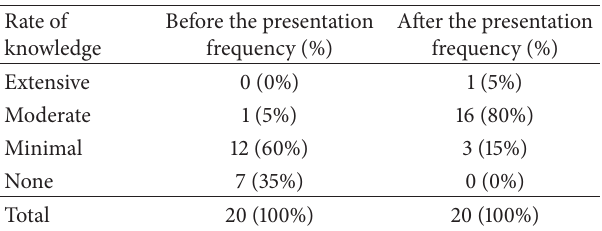
Table 2: The answers to the question “how would you rate your knowledge of oral health for person with SHCN” before and after the presentation/educational